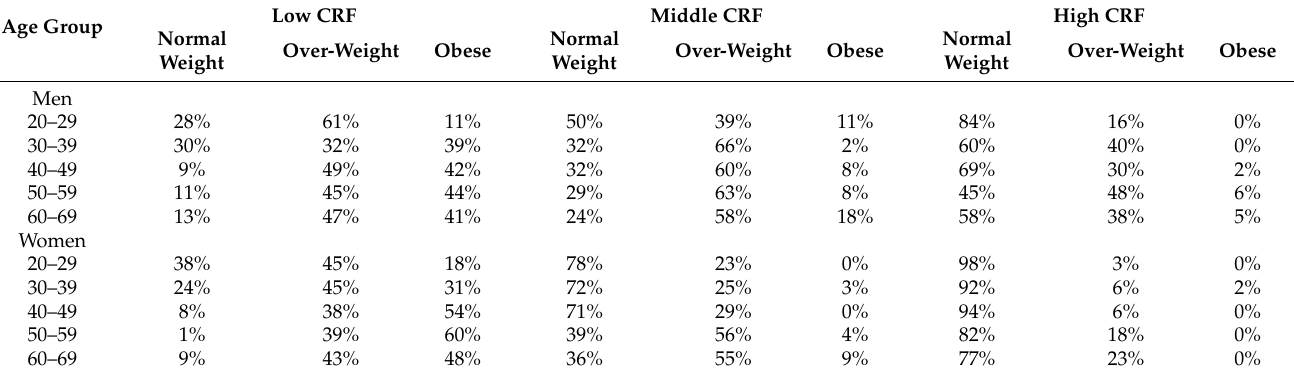
Table 2. Proportion of participants in each BMI groups (normal weight, overweight, and obese) in CRF tertiles broken down by sex and age